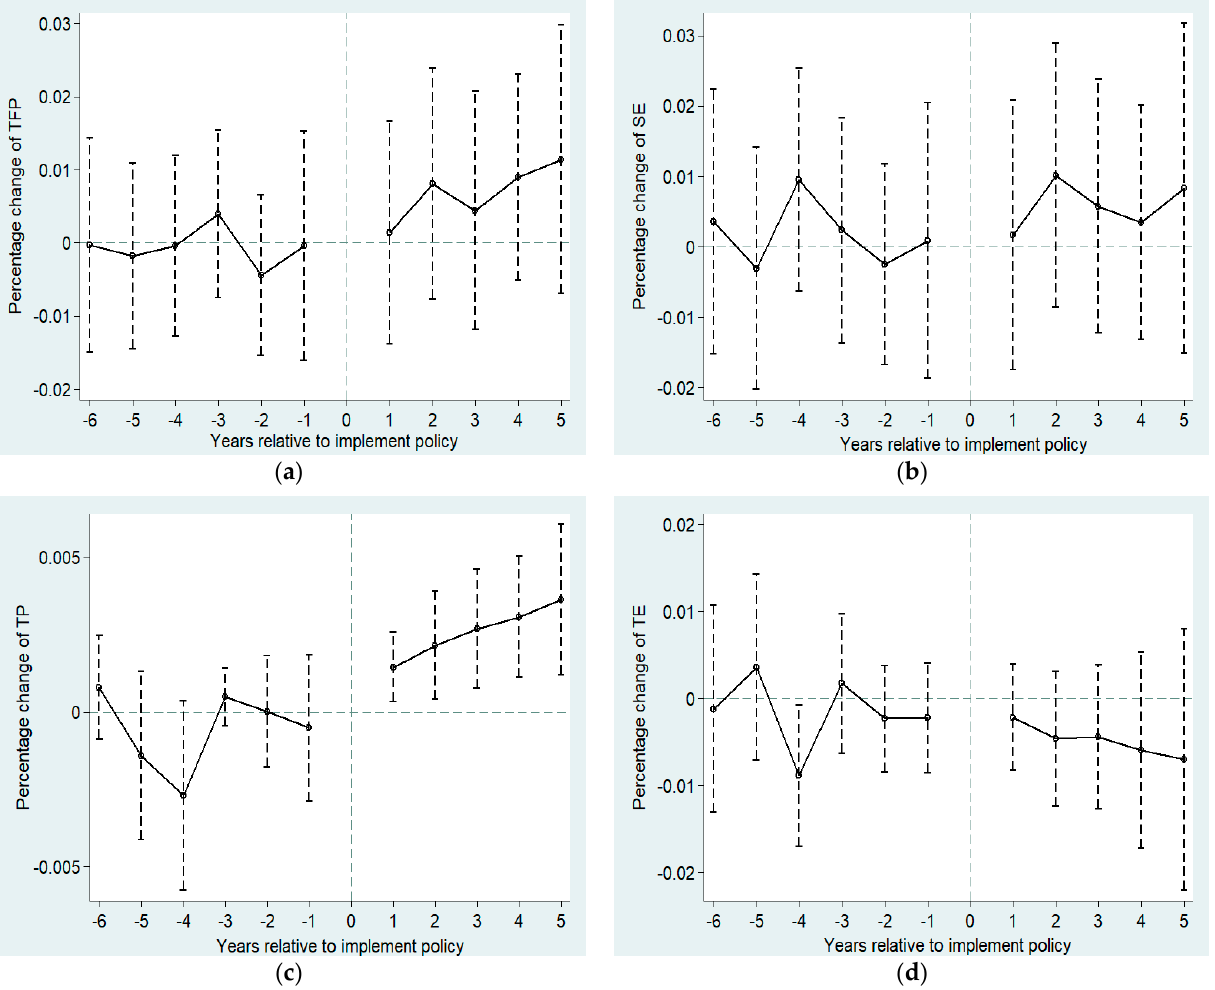
Figure 2. Parallel trend test. The horizontal axis indicates the years before and after the policy’s implementation. The vertical axis represents the percentage change in each variable of the experimental and control groups. ( a – d ) describe the percentage changes in TFP, SE, TP and TE differences between the experimental group and the control group,